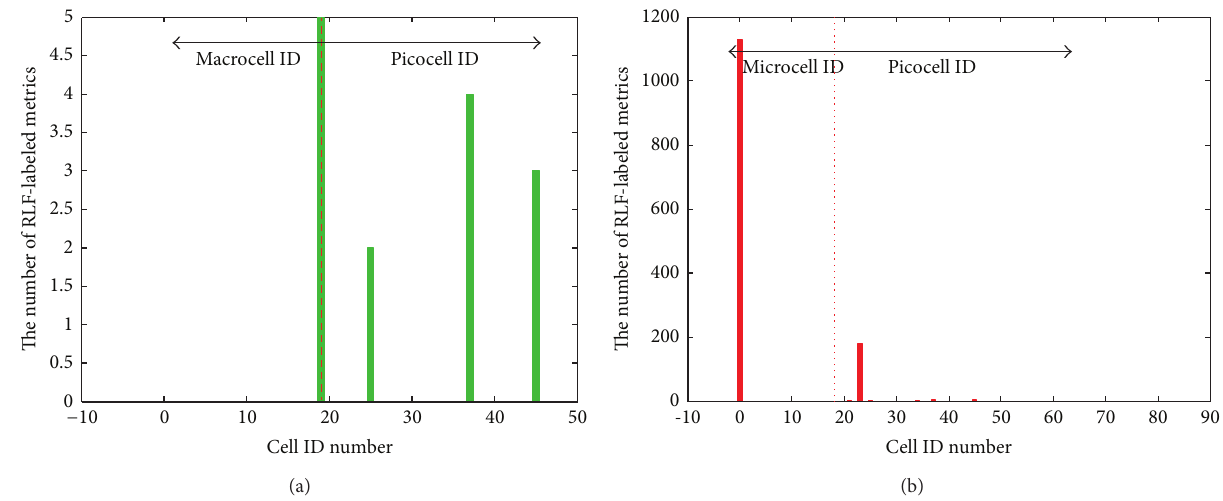
Figure 4: The distribution of RLF-labeled data based on CGI information: (a) the distribution in the reference simulation and (b) the distribution in the problematic simulation.